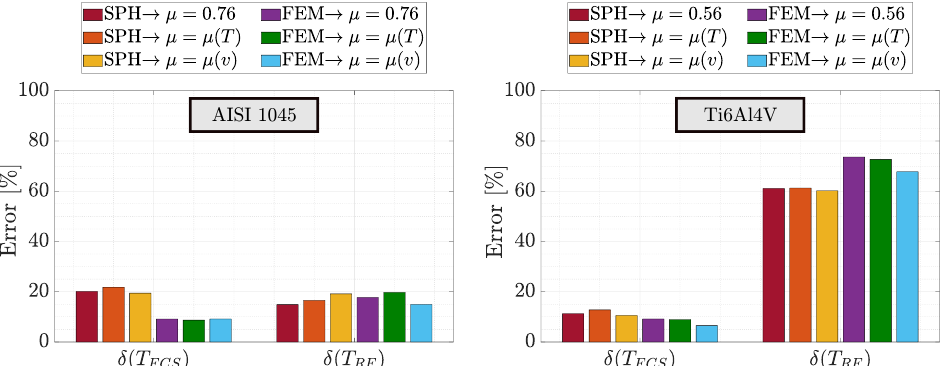
Figure 11. Relative error of numerical simulations in predicting the free chip surface and rake face temperatures. Each error bar represents an average of 9 data points resulting from the variation of 3 cutting velocities and 3 uncut chip thicknesses for each material, as listed in Tables 2 and 3, where γ = 0 ◦ , α = 10 ◦ , and r β = 10 µ m in all